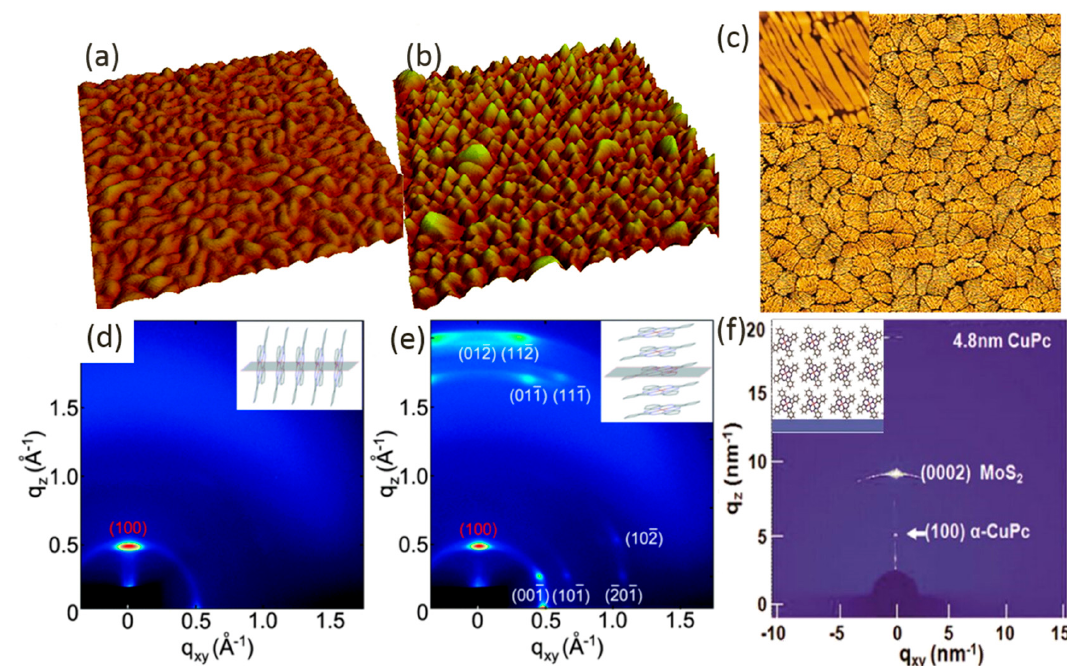
Figure 4. The AFM morphologic images and 2D-GIXRD images of CuPc on glass ( a,d ), G-covered glass ( b,e ), and bulk MoS 2 ( c,f ), respectively. The insets show the corresponding CuPc packing. Panel a, b, d, e is reproduced from [45] with permission from The Royal Society of Chemistry. Panel c, f is reprinted with permission from [50], copyright 2015 American Chemical Society.